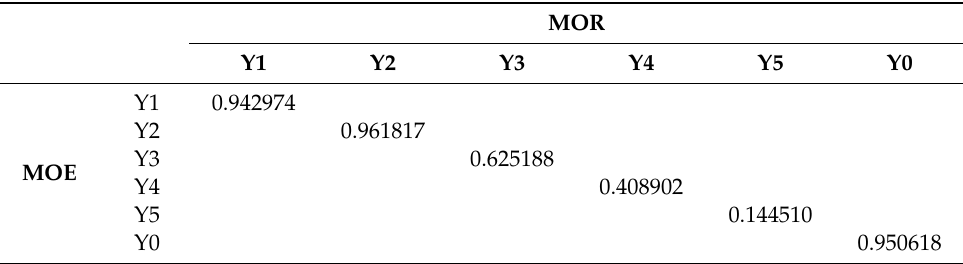
Table 3. Intra-group correlations between MOR and